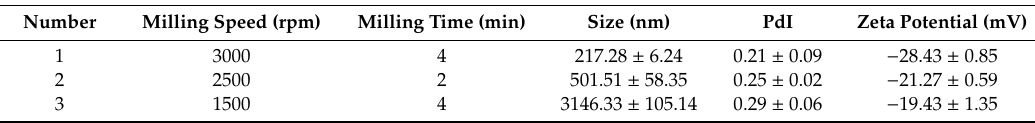
Table 1. Preparation process and characterization of the three quercetin nanocrystals (QE-NCs) with di ff erent particle sizes ( n =